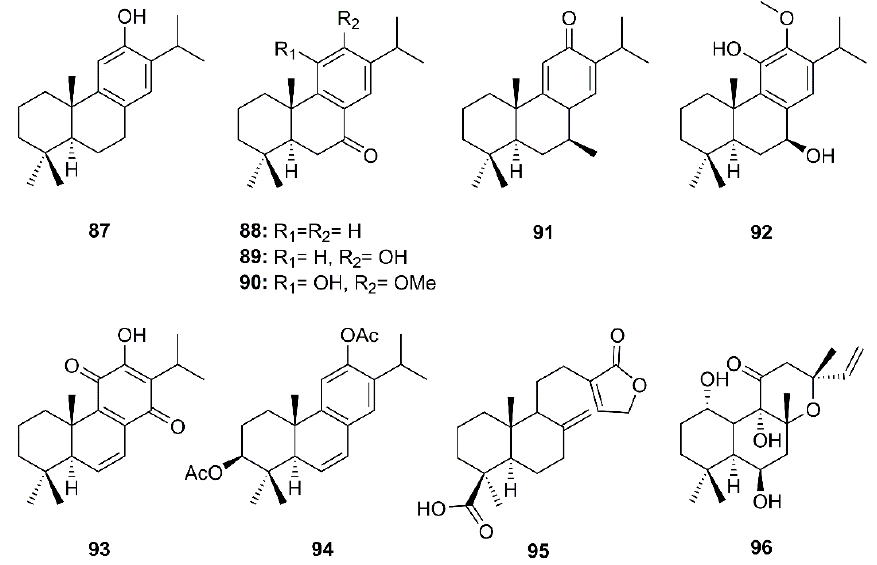
Figure 15. Structures of abietane ( 87 – 94) and labdane ( 95 and 96 ) diterpenoids. Six abietane diterpenes, 18-hydroxyferruginol ( 97 ), hinokiol ( 98 ), ferruginol ( 87 ), 18- oxoferruginol ( 99 ), O -acetyl-18-hydroxyferruginol ( 100 ), methyl dehydroabietate ( 101 ), one primarane diterpene, isopimaric acid ( 102 ), and one labdane diterpene, kayadiol ( 103 ) (Figure 16), isolated from the n -hexane fraction of leaves of T. nucifera L. Siebold and Zucc. (Lamiaceae), were investigated for their inhibitory activities against SARS-CoV 3CL pro by using a FRET assay. Compounds 97 – 103 displayed inhibition against SARS-CoV 3CL pro